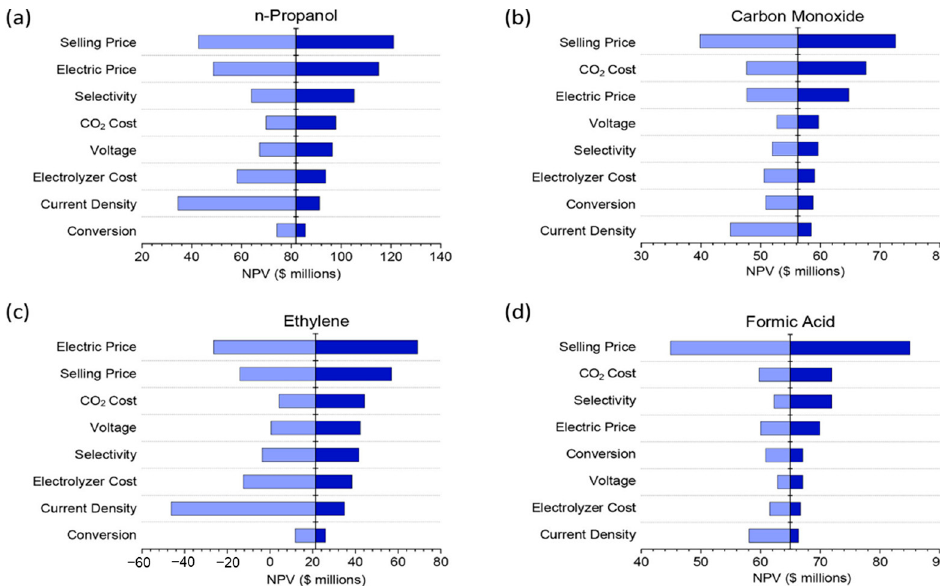
Figure 1. Sensitivity analysis of end-of-life net present value (NPV) for CO 2 -reduction products: ( a ) n -propanol, ( b ) carbon monoxide, ( c ) ethylene, and ( d ) formic acid. Adapted from Jouny et al. Reprinted with permission from ref. [9]. Copyright 2018,